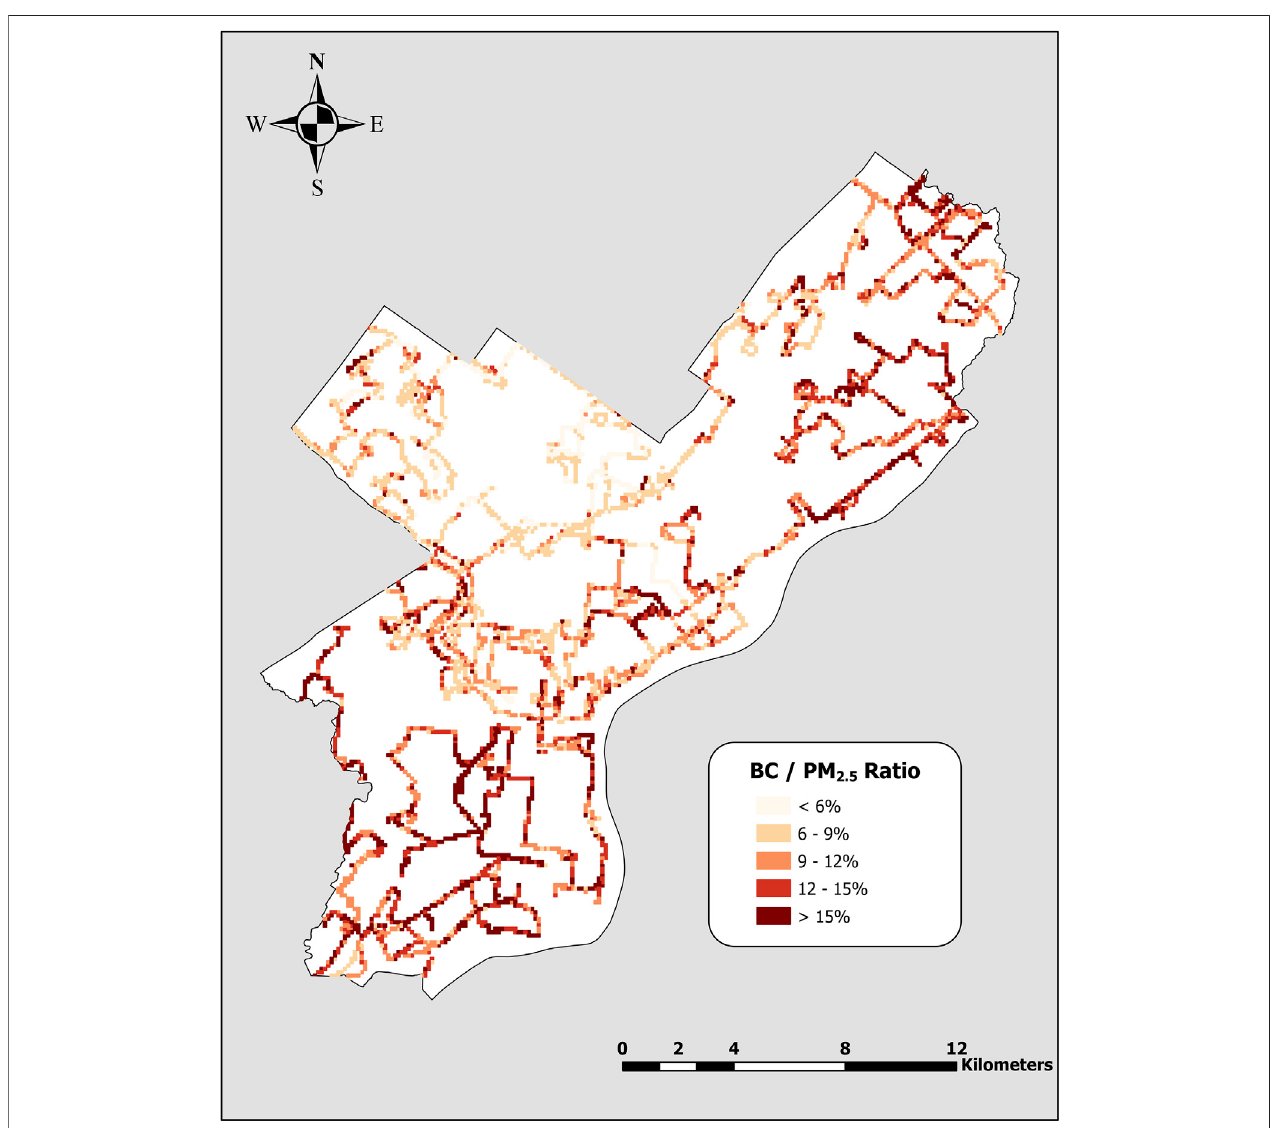
FIGURE 4 | Daily average of the ratio of BC to fi ne PM (PM 2.5 ) in each 120 m 2 cell. BC/PM ratios are classi fi ed using quantiles.